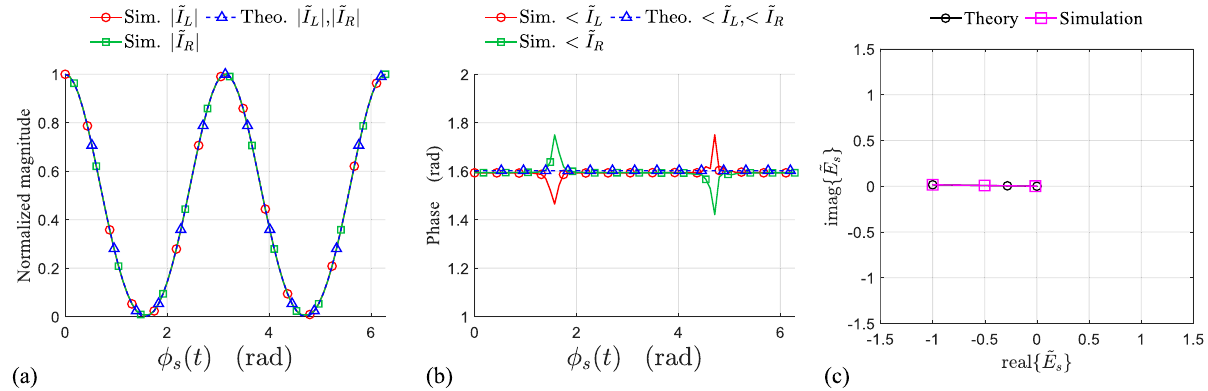
Figure 4. ( a ) Normalized magnitude, ( b ) phase of the induced currents on the left and right side of the symmetrically rotating rectangular loop during one period of rotation, obtained from the model and simulations. ( c ) IQ constellation of the time-varying complex envelope of the normalized backscattered field from symmetrically rotating loop in simulation and theory.